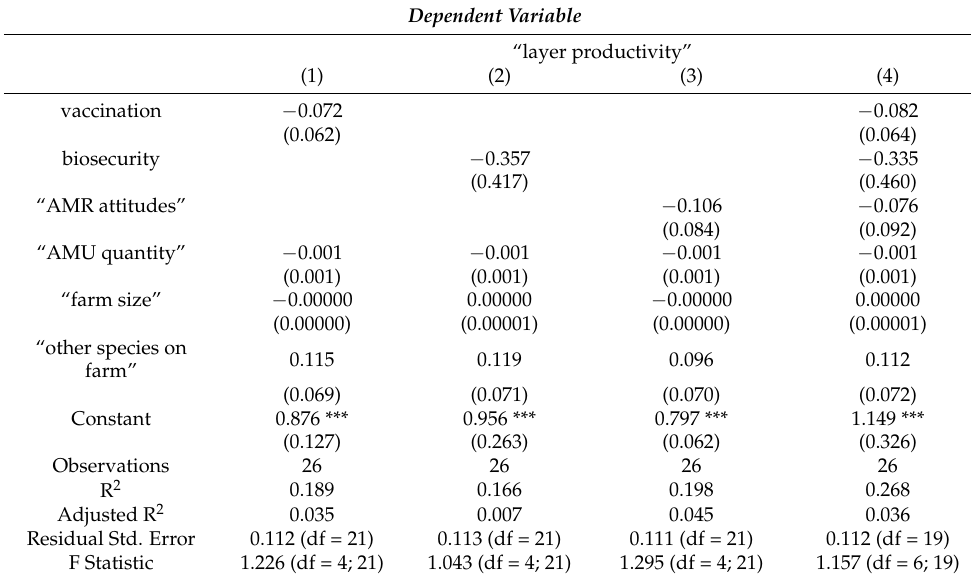
Table 6. Determinants of productivity